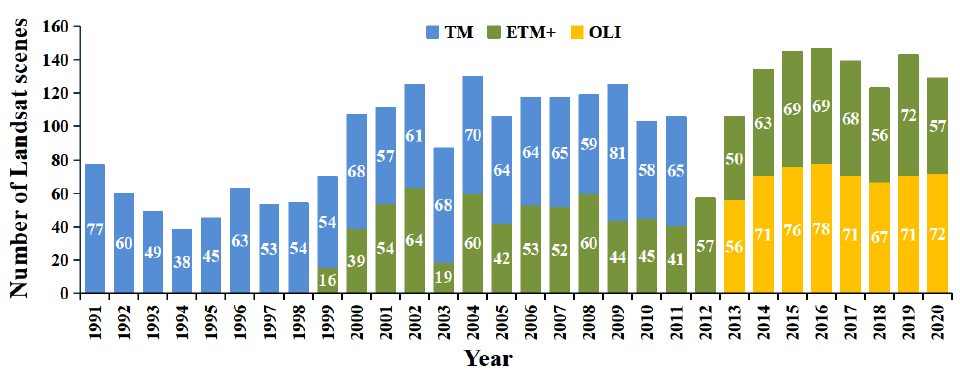
Figure 3. Number of Landsat-5 TM, Landsat-7 ETM+, and Landsat-8 OLI scenes analyzed in this study, available annually from 1991 to 2020.